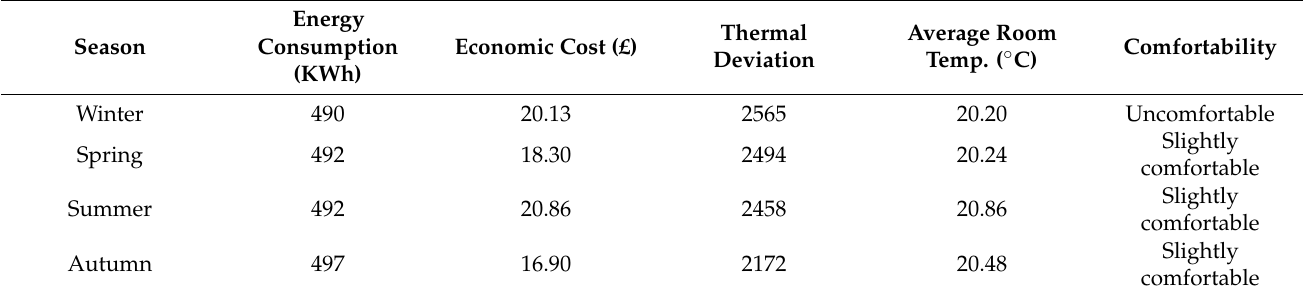
Table 4. Summary of results for all four seasons considered.